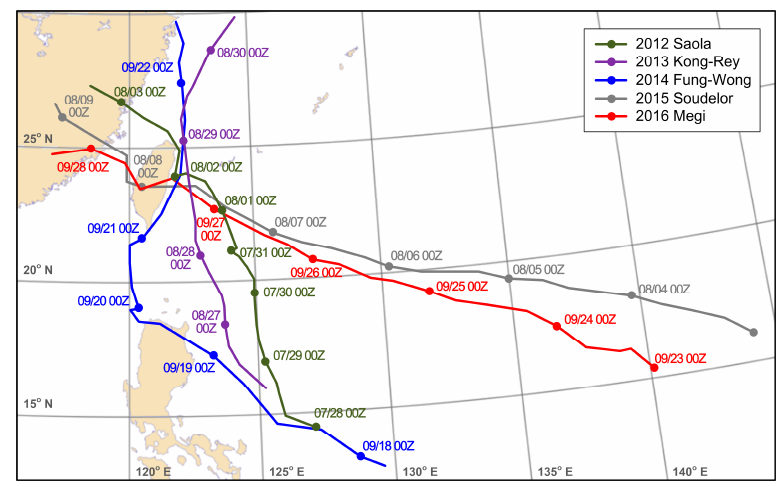
Figure 5. Observed typhoon tracks of five typhoons used herein.